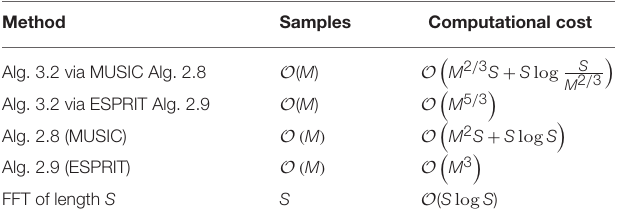
TABLE 4 | Numbers of required samples and computational costs using the splitting approach for one iteration of Algorithm 3.2 as well as for Algorithms 2.8 and 2.9 in the case K = O ( M 1 / 3 ) , P = O ( M 2 / 3 ) and M ≈ L / 2 ≈ N / 4 . Method Samples Computational